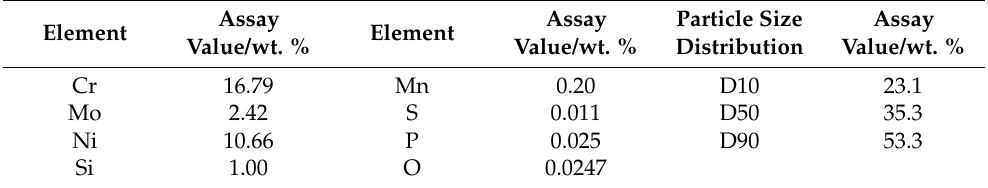
Figure 3. SEM image of the 316L stainless steel powder [28]. Table 2. Chemical composition and particle size distribution of the 316L stainless steel powder [28].